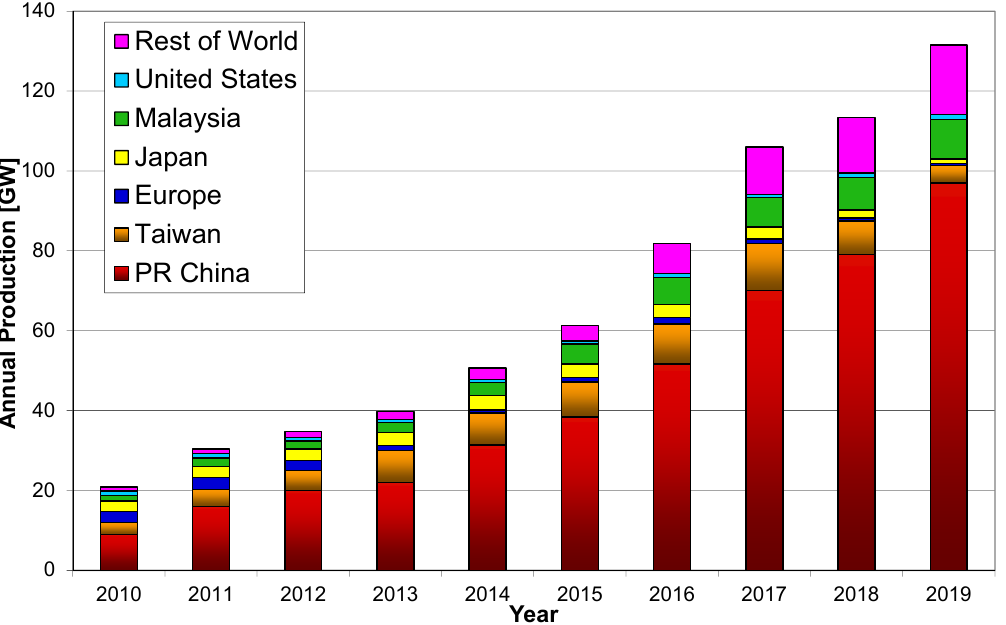
/ Module Production from 2010 to 2019 (data source: [4] and new Figure 1. World PV Cell/Module Production from 2010 to 2019 (data source: [4] and new analysis). Figure 1. World PV Cell